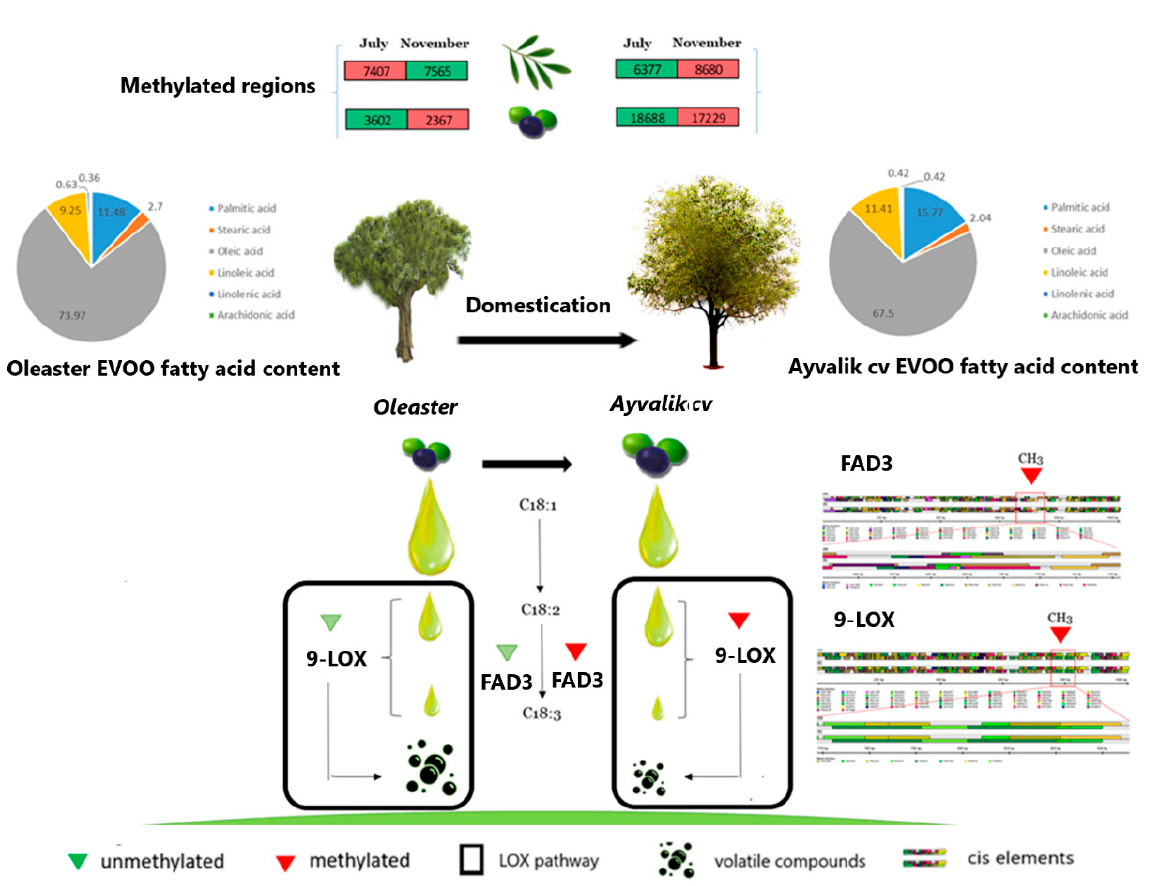
Figure 4. Scheme summarizing the effect of DNA methylation during olive domestication on the sensory quality of olive oil.